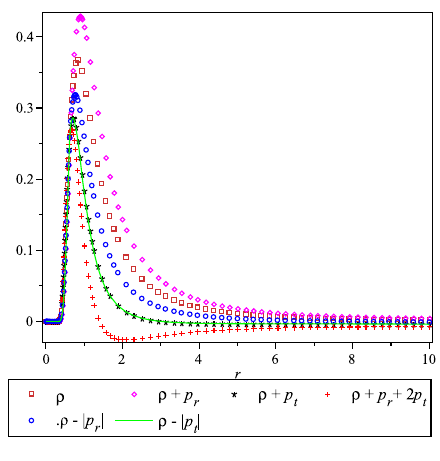
( d ) This figure depicts the behavior of all EC terms for Model-II in Subcase 8 ( ξ 2 > 0, α 2 < 0, α < 0). All ECs are found to be satisfied for every r > 0 . 5.